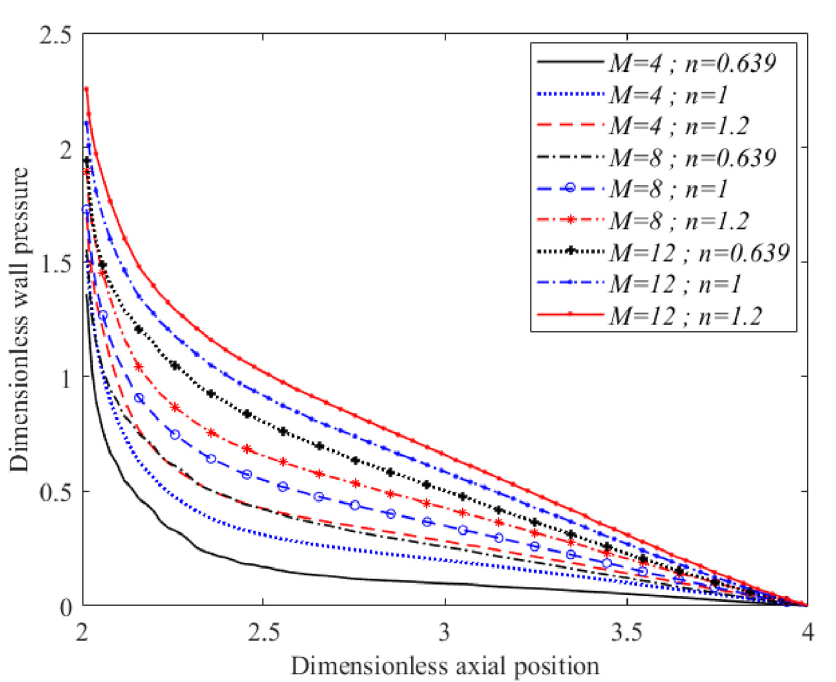
Fig 10. Wall pressure distribution along the inner arterial wall for different in Hartmann number and fluid characterisation (Re = 300 and τ = 0.2 a m